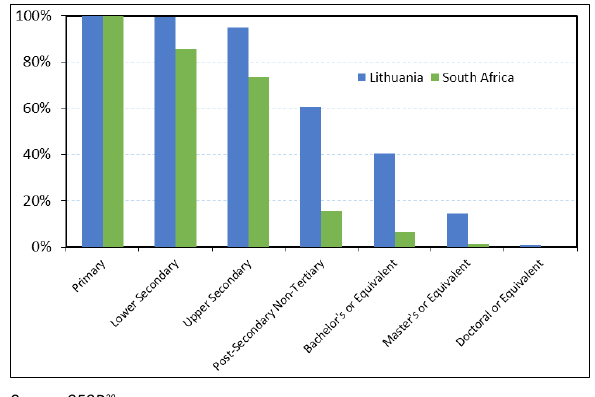
figure 1: Education attainment levels in Lithuania and South Africa, 2016. In combination with higher levels of gross expenditure on research and development, this emphasis on human capability development has had a radical impact on economic development and per capita income, as shown in Figure